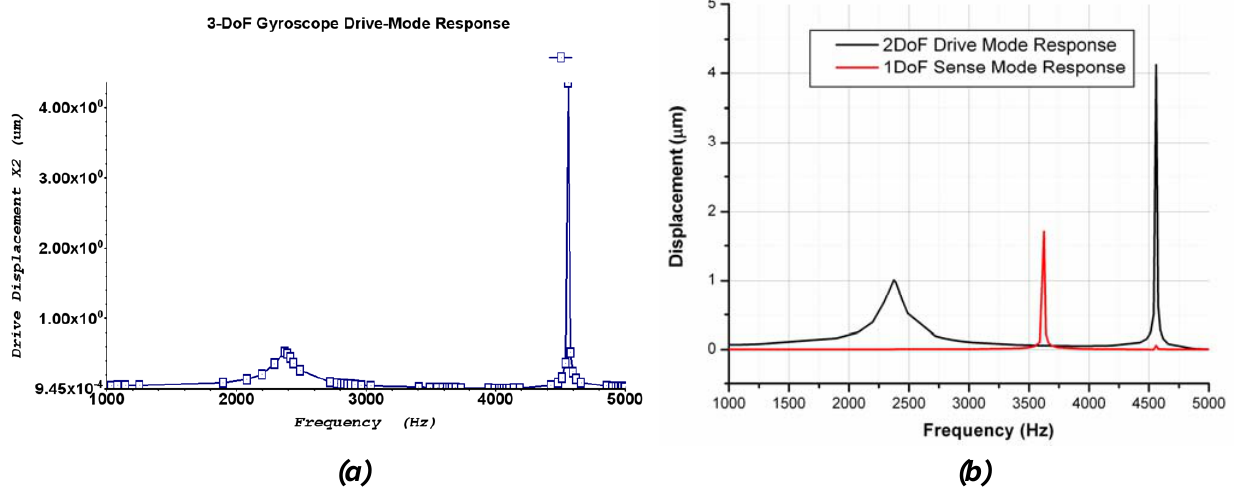
Figure 15. (a) 2-DoF Drive mode oscillator frequency response: showing the 1 st and 2 nd resonant frequency peak at 2.32 kHz and 4.43 kHz, respectively. (b) Combined response of 3-DoF gyroscope with 2-DoF Drive and 1-DoF sense-mode oscillator demonstrating that the sense mode resonant frequency is located inside the drive-mode flat